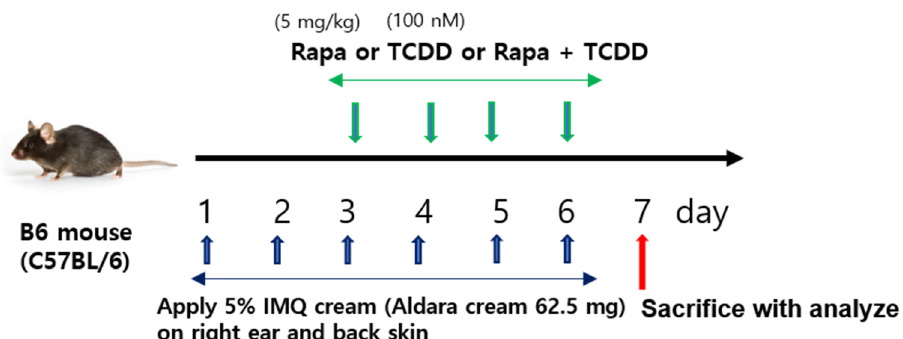
Figure 1. Study procedures. C57BL/6 mice were treated on the dorsal skin and right ear pinna for 4 days with five different treatment regimens as described in the Materials and Methods section. C57BL/6 mice were treated daily with vehicle control, IMQ, IMQ + TCDD, IMQ + Rapa, or IMQ + TCDD + Rapa applied on their shaved back skin and right ears. IMQ: imiquimod, Rapa: rapamycin.